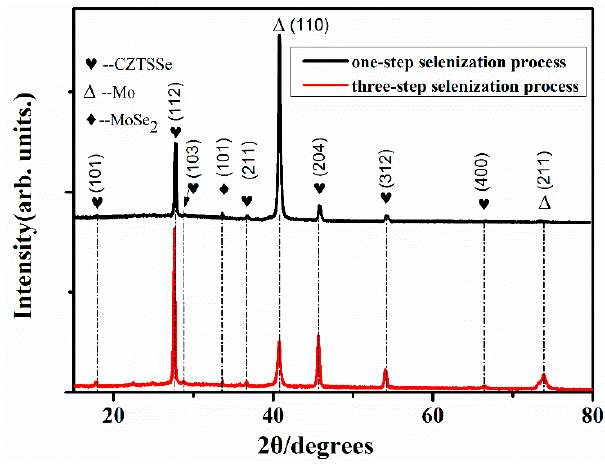
Figure 2. XRD patterns of CZTSSe film with the one-step and three-step selenization process.